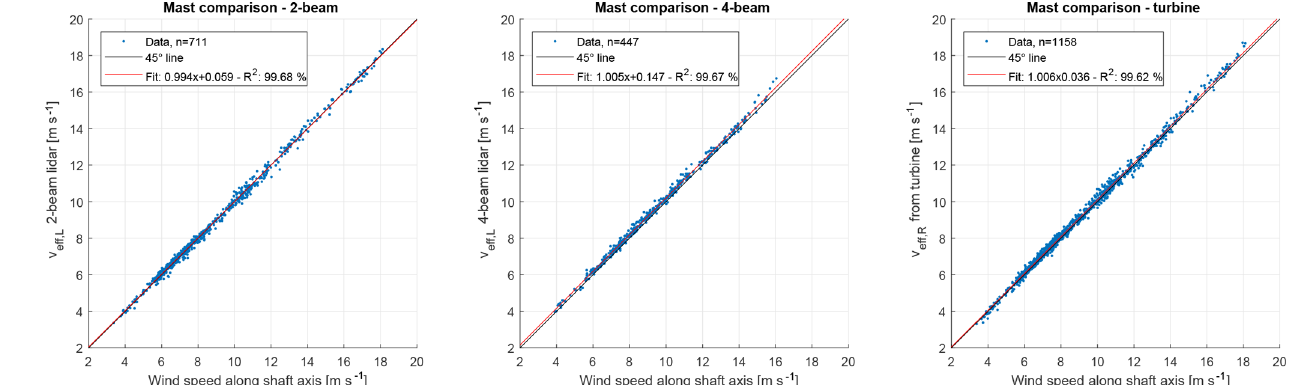
Figure 6. Comparison of 10min REWS estimates from of the lidars and the turbine to the meteorological mast’s sonic anemometer. The data were taken from periods when the turbine was operational and facing the mast.